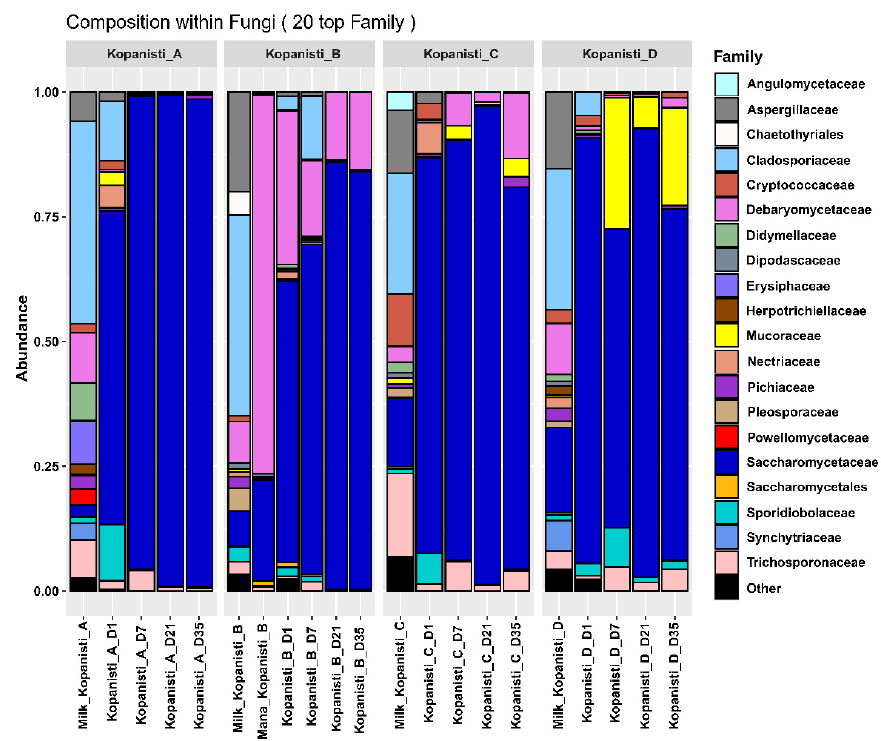
Figure 5. Composition plots of the relative abundances of the 20 most abundant yeasts/fungi zOTUs taxonomically assigned at the family level in pasteurized milk, Mana Kopanisti and Kopanisti cheese samples. Samples from each Kopanisti type (A–D) are presented together in subpanels.